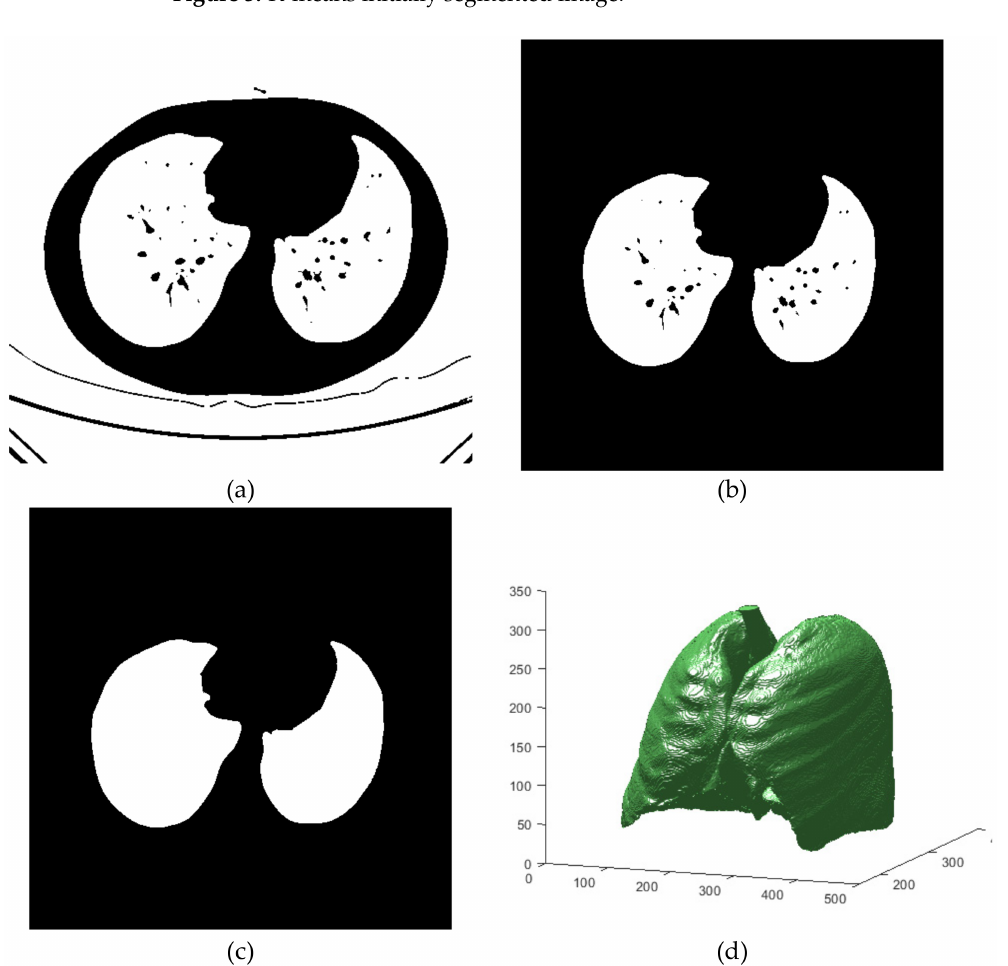
Figure 4. Lung mask extraction. ( a ) Binary K-means result; ( b ) remove edges and small objects; ( c ) 3D closed operation result; ( d ) 3D reviewed lung mask extraction